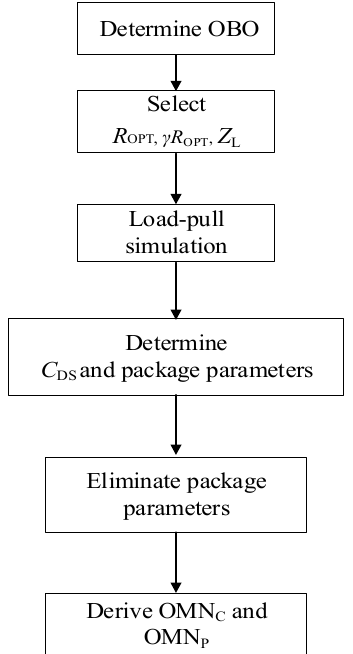
Figure 8. PA branch topology with device parameters.